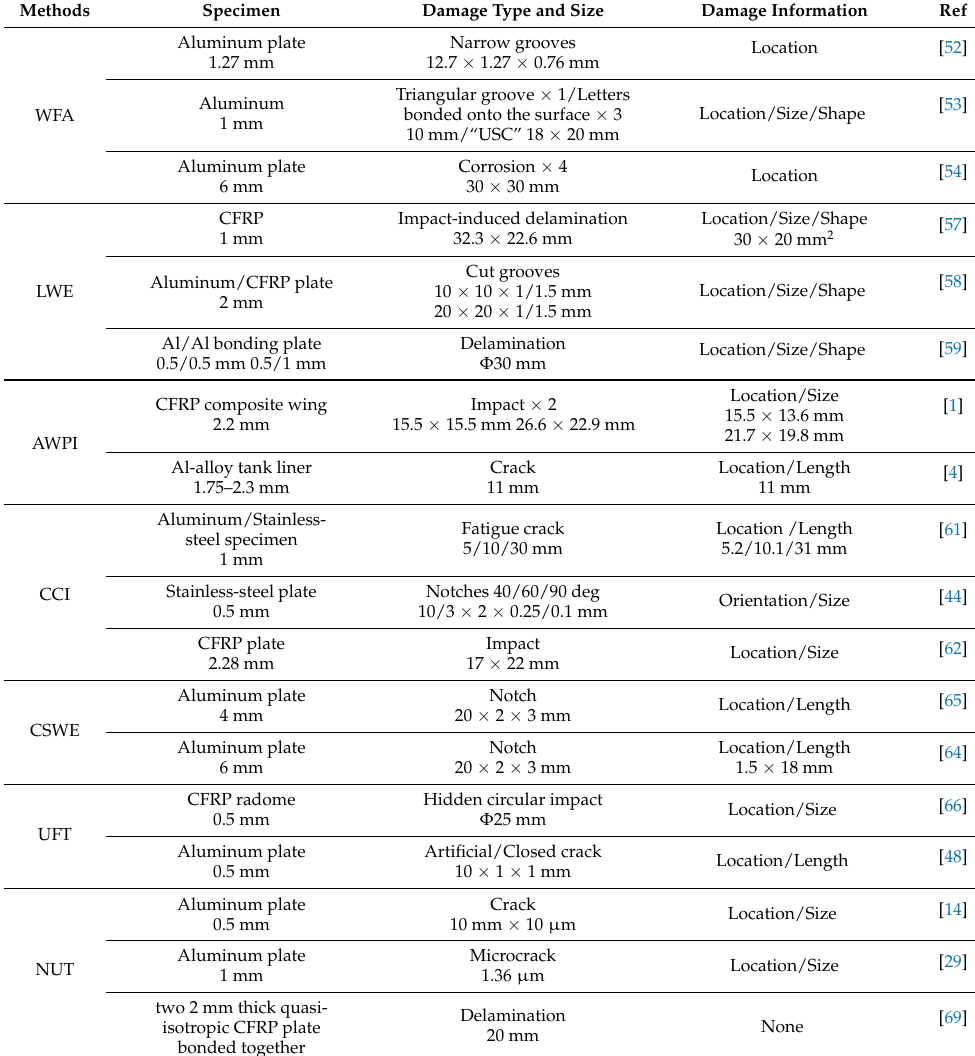
Table 1. Laser ultrasonic detection results based on full wavefield data from the relevant literature.